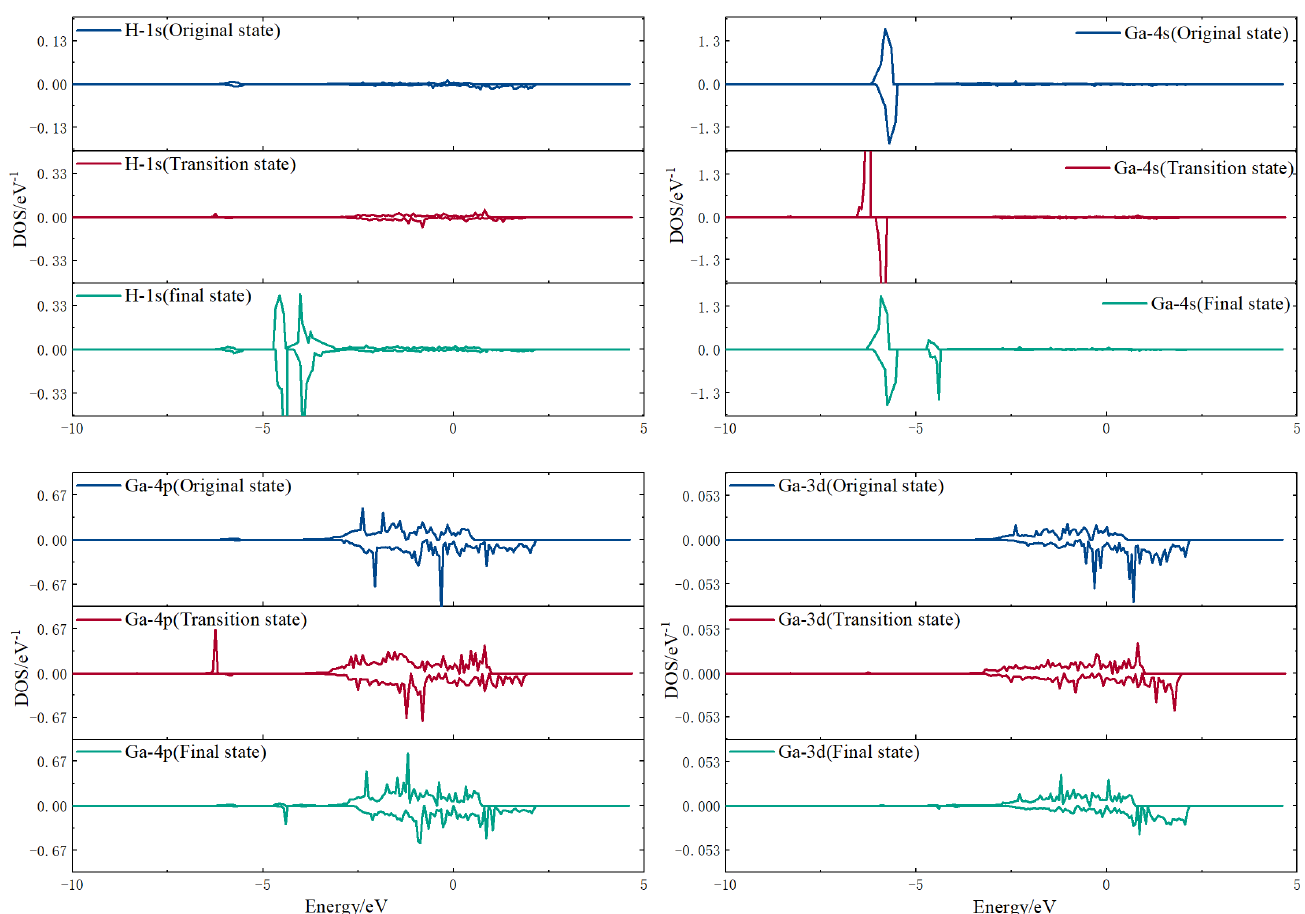
drogen atom and the nearest plutonium and gallium atoms, respectively. The comparative diagrams of the density of states for the three states are shown in Figures 10 and 11.